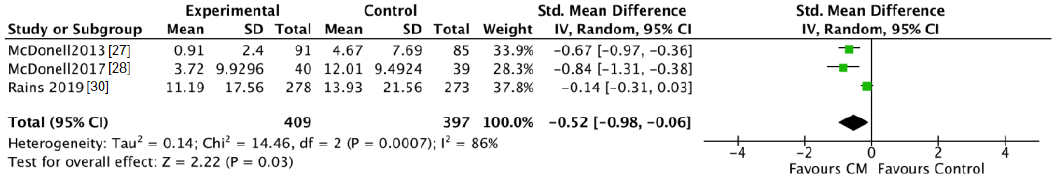
Figure 2. Forest plot of the comparison CM versus standard care after intervention, number of days using.